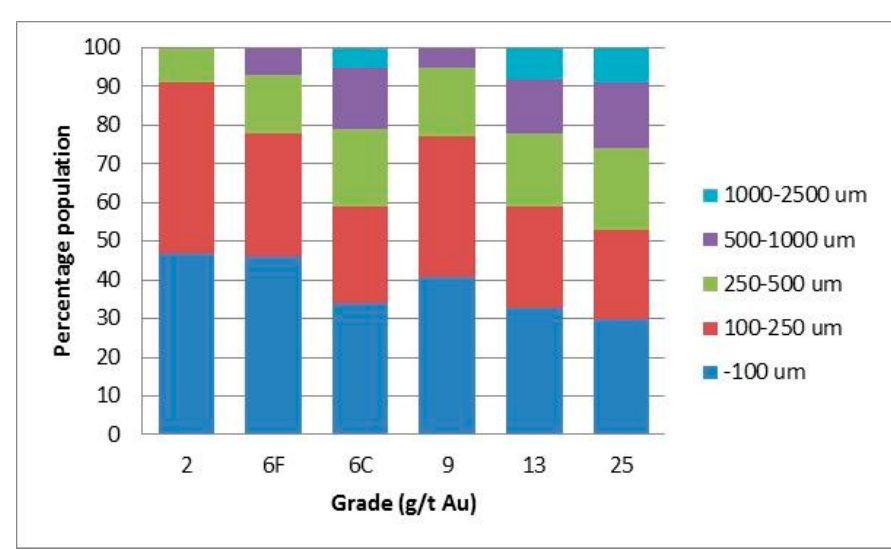
Figure 5. Gold particle size distribution by mass across different grades on the Veta Christina reef.